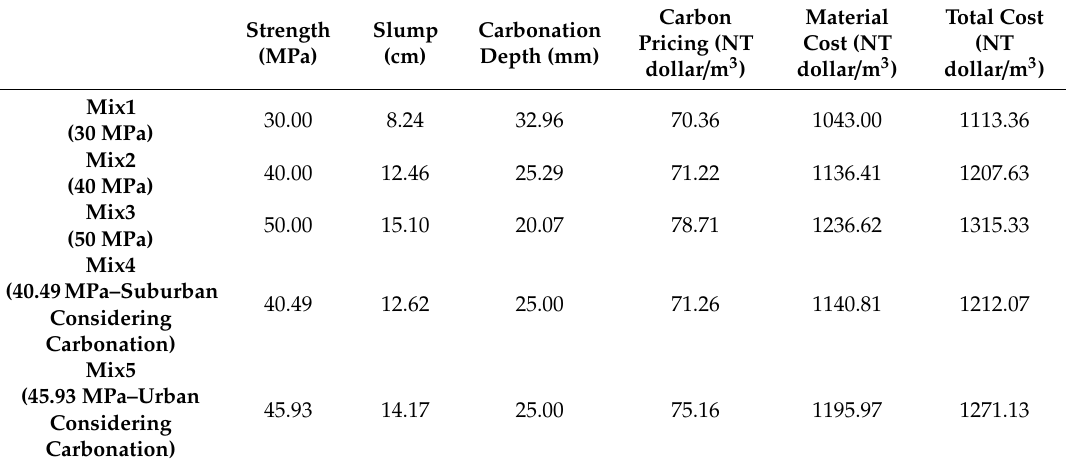
Table 7. The performance of the